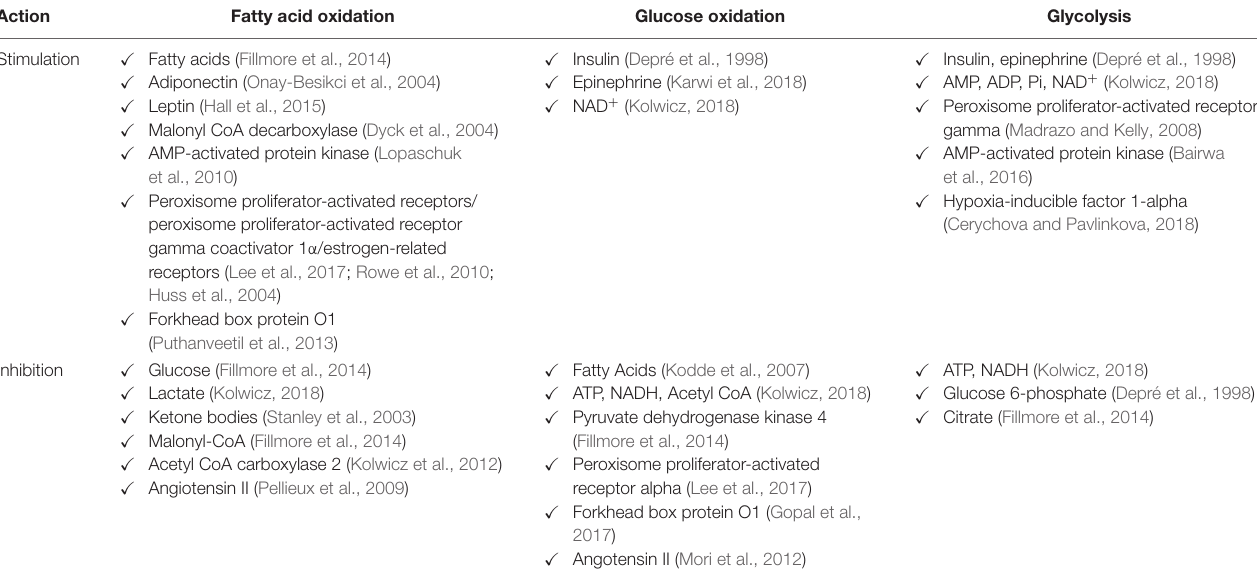
TABLE 4 | Main regulators of glucose and fatty acids metabolism in the heart. Action Fatty acid oxidation Glucose oxidation Glycolysis